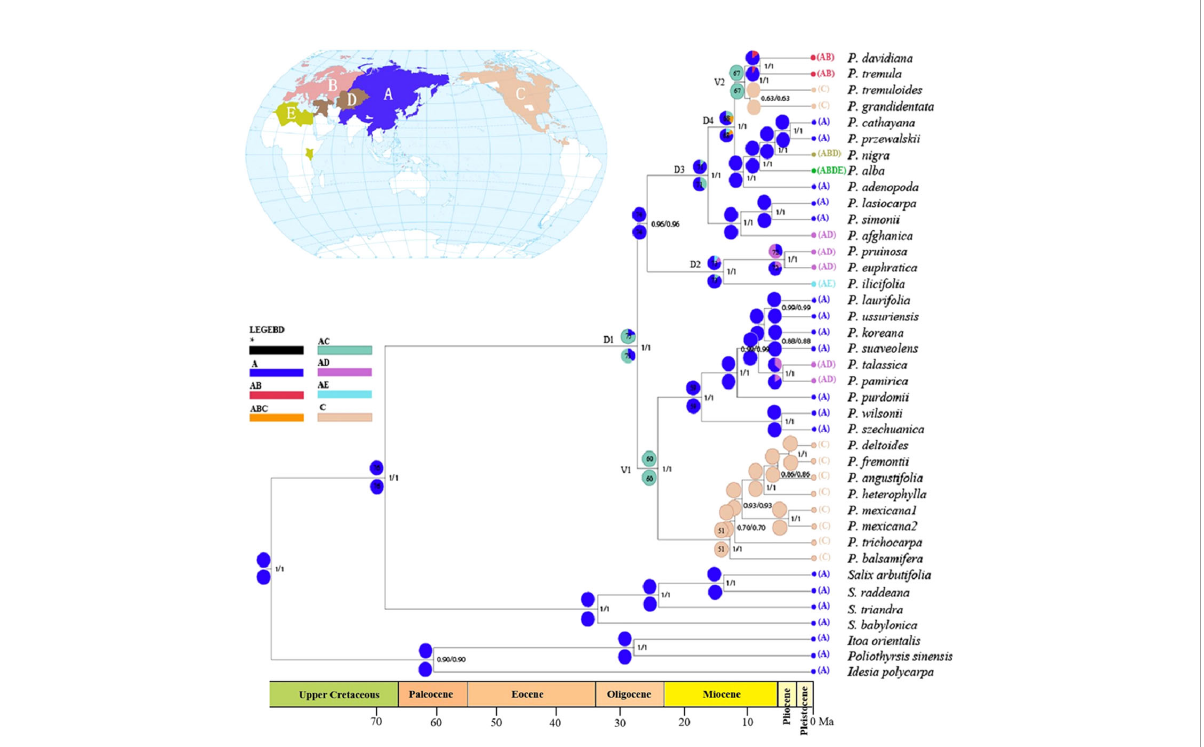
FIGURE 4 Ancestral area reconstruction for Populus based on statistical dispersal-vicariance analysis (S-DIVA) and dispersal-extinction-cladogenesis (DEC) overlaid onto the maximum clade credibility chronogram from BEAST. Current distributions are indicated before the species names. Five areas were de fi ned: (A) Asia and neighboring areas, (B) Europe, (C) North America (including Mexico), (D) Center Asia, and (E) North Africa; black with an asterisk represents other ancestral ranges. Pie charts at nodes indicate probabilities of alternative ancestral ranges obtained by DIVA (below) and DEC (above). D1 – 4 and V1 – 2 indicate dispersal and vicariance events, respectively. Nodes of interests were marked as 1-11 in pie